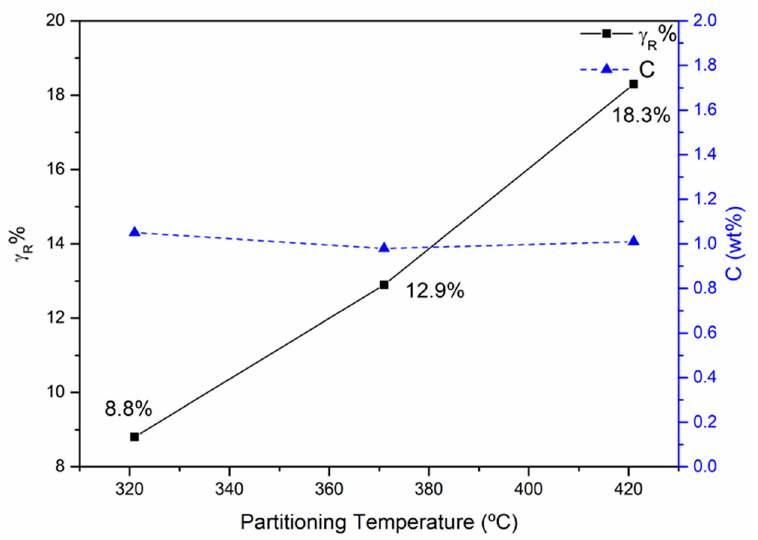
Figure 10. Retained austenite volume fraction and carbon amount in wt% obtained by XRD.